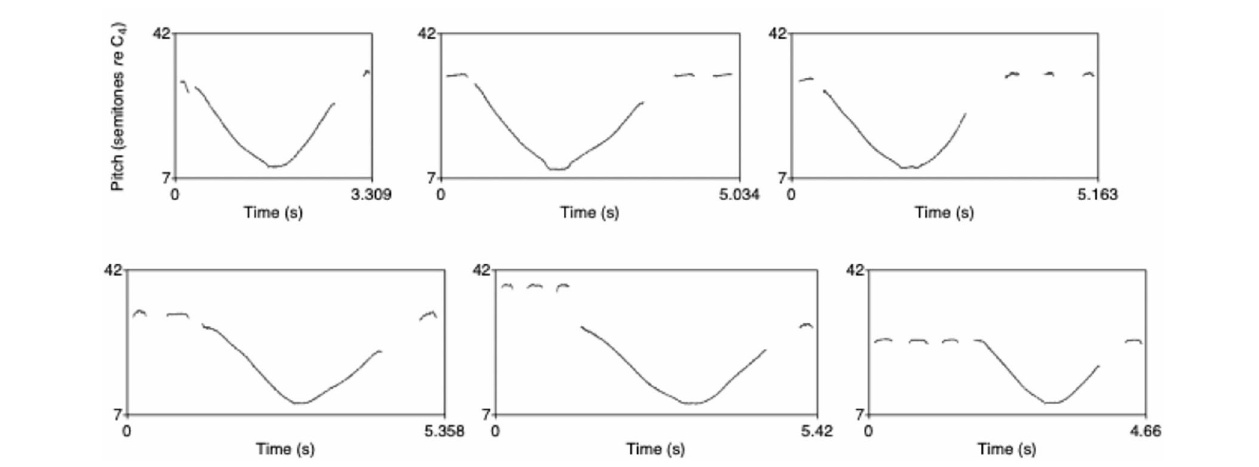
FIGURE 11 | Fragment of the whistles plotted as pitch tracks on a semitone scale in the last set of a chain. Basic elements can be identified that are systematically recombined. Reprinted with permission from Verhoef